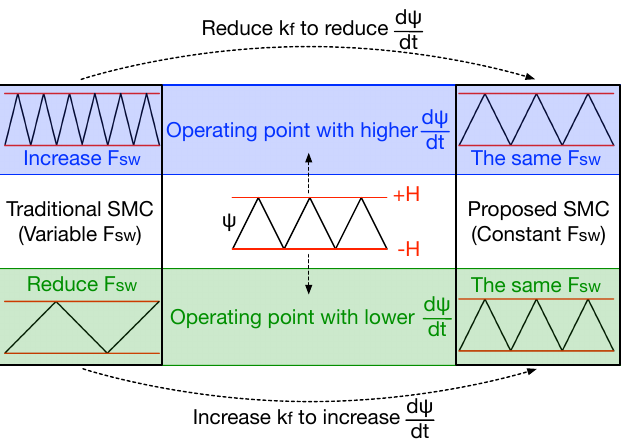
Figure 5. Switching frequency ( F sw ), hysteresis band ( H ) and d Ψ